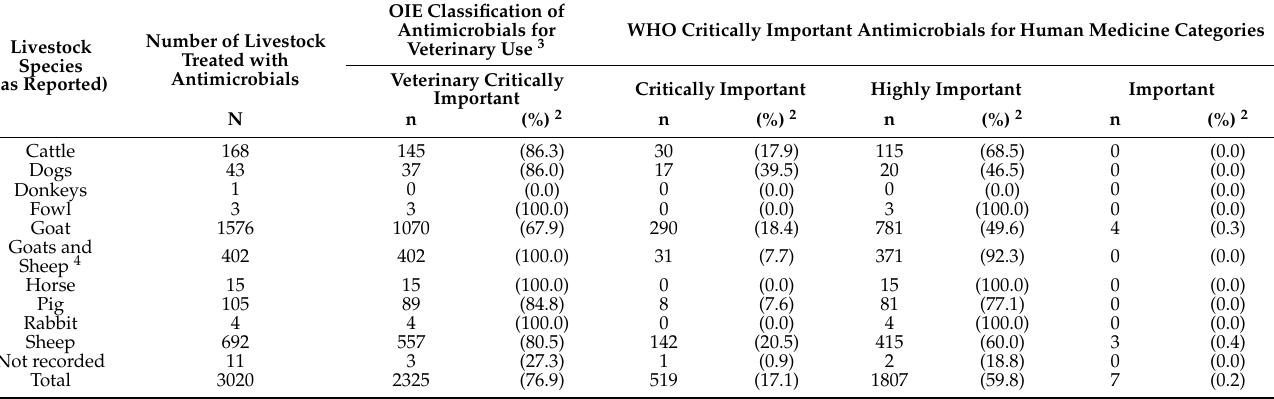
Table 3. Antimicrobial use based on OIE list of antimicrobial agents of veterinary importance and World Health Organization list of critically important antimicrobials for human medicine in Sierra Leone, March–October 2021 1 .